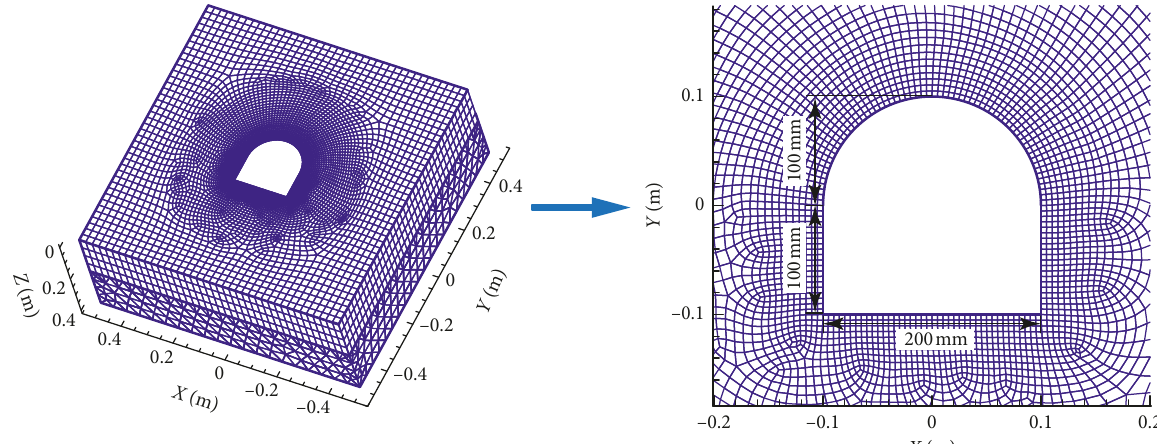
Figure 7: Numerical grid used to model the horseshoe tunnel.